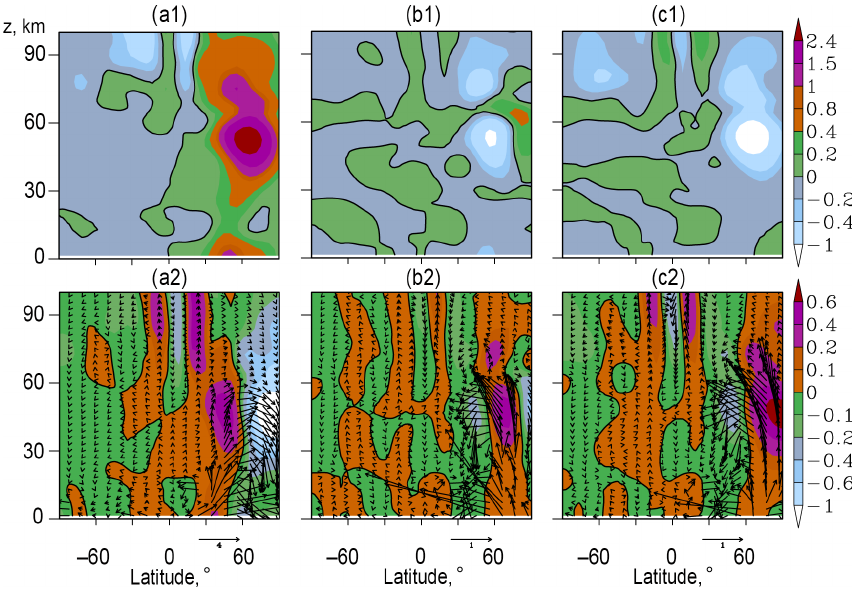
Figure 4. The same as Fig. 3 but for the meridional and vertical components of the wave-induced eddy circulation.